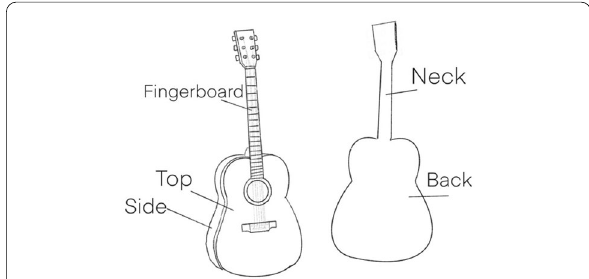
Fig. 3 Parts of acoustic guitars. Figure created by the authors. In our data set, the wood used for the sides and backs was the same for all guitars. Therefore, this study set the variable as “side back” instead of separating